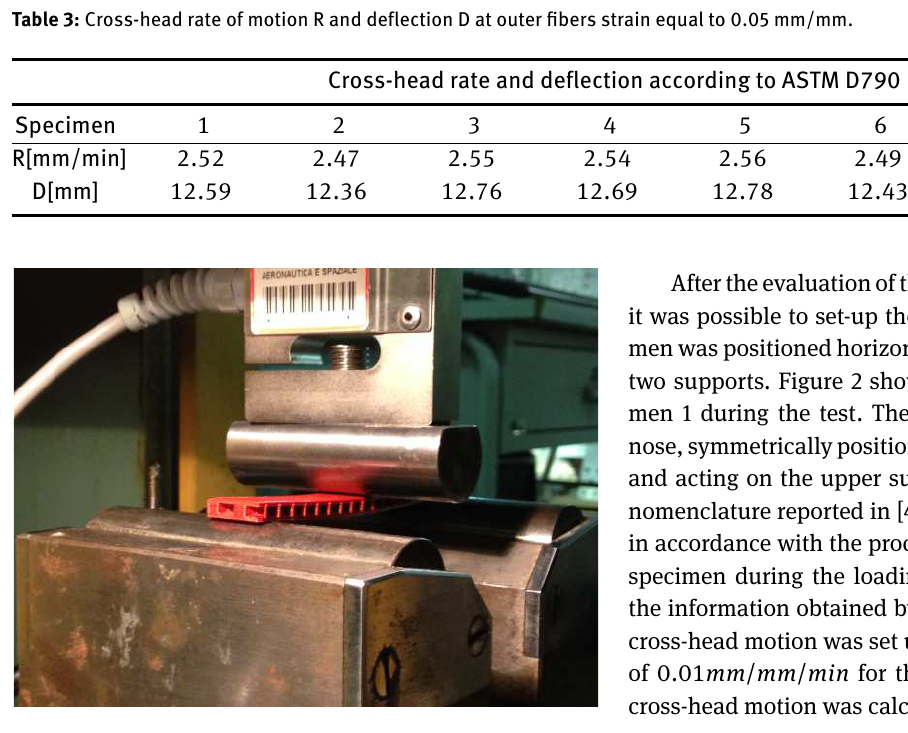
Figure 2: Specimen 1 during the three-point bending test.